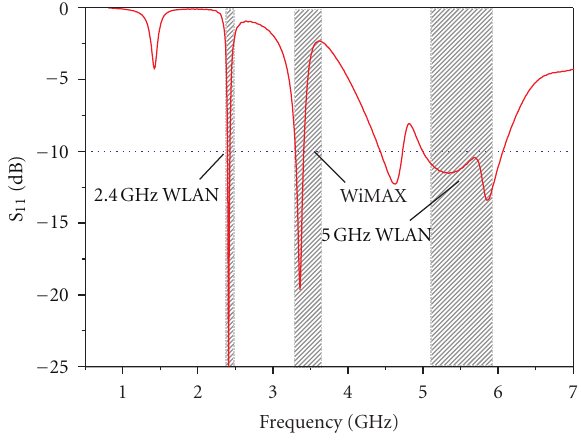
Figure 4: S 11 results of the flexible Hilbert-curve loop antenna.